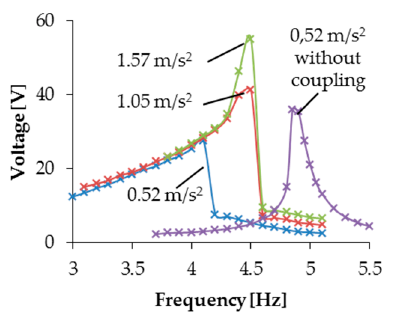
Figure 8. Open circuit voltages measured without and with magnetic coupling at different